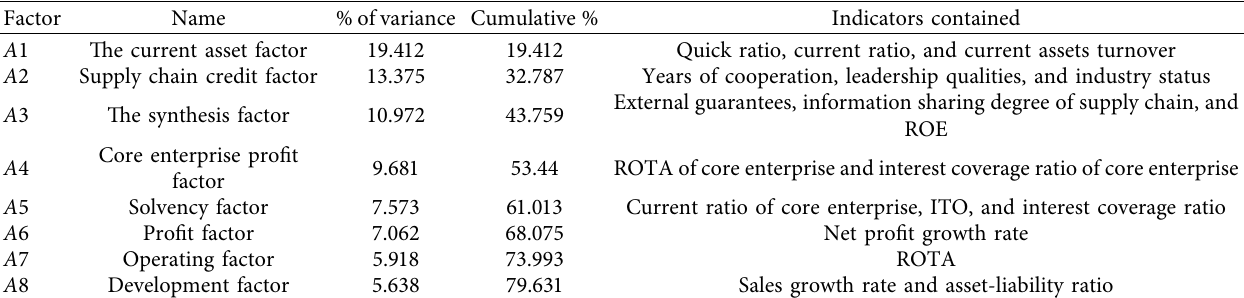
Table 5: Factor explanation table (clothing